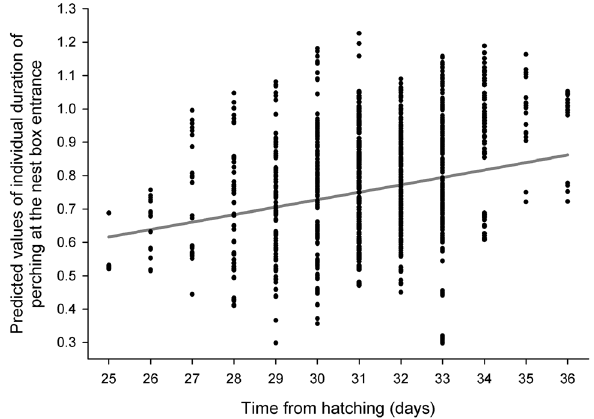
Figure 4. Predicted values of the log-transformed individual duration of nestlings’ perching at the nest box entrance during the night plotted against the time from hatching (nestlings’